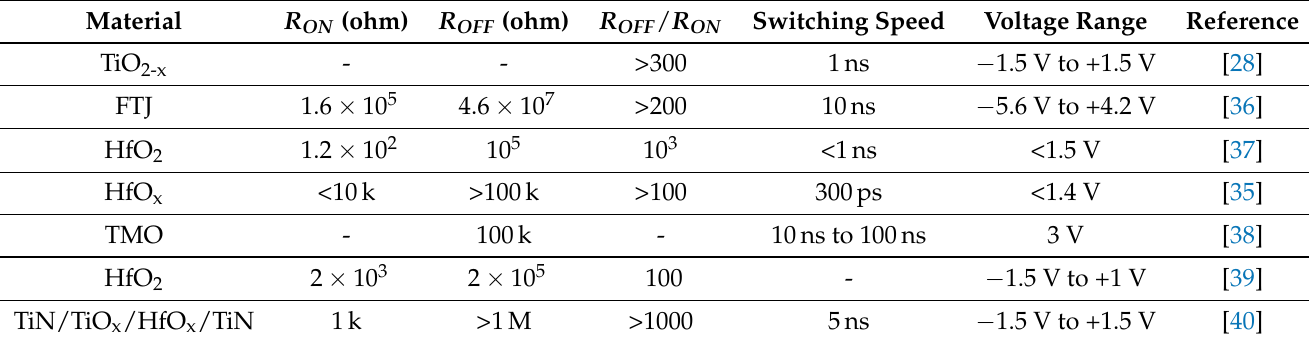
Table 1. Practical memristor